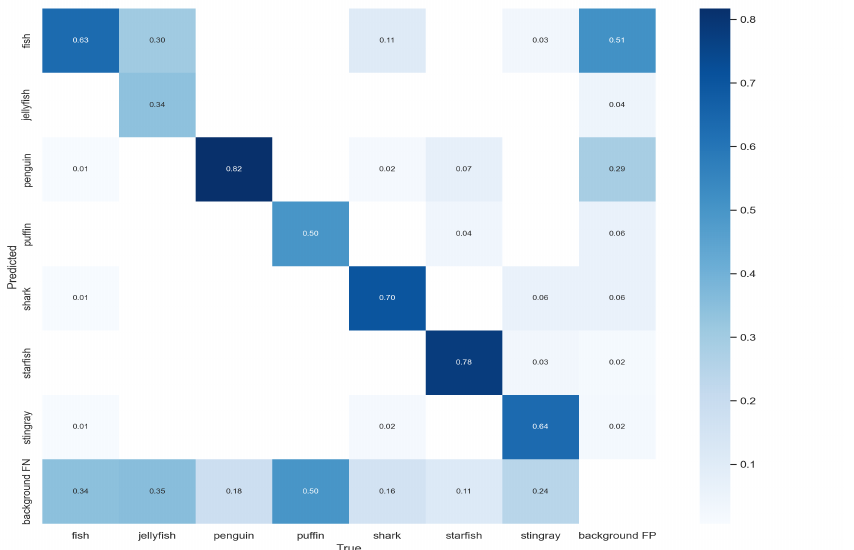
Figure 16. Confusion matrix on Aquarium Combined dataset; the darker the color, the higher the detection accuracy.